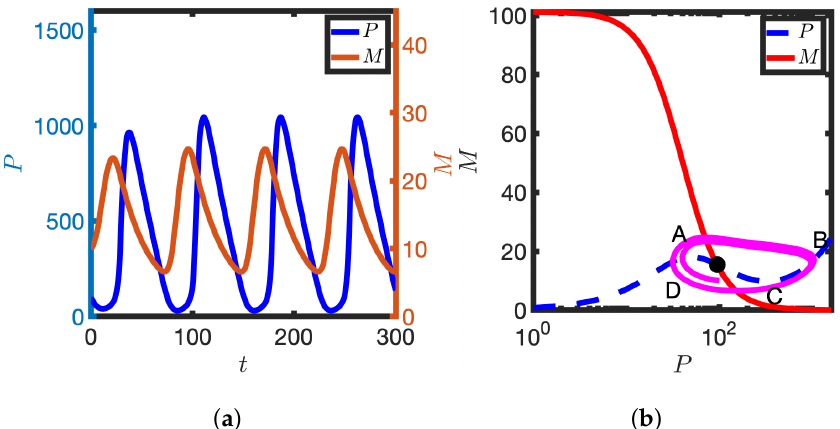
Figure 5. Oscillatory solutions of Equation (2). ( a ) P and M are plotted against time, t . ( b ) Corre- sponding solution (magenta line) is plotted in the PM phase plane. P nullcline (dashed blue line), M nullcline (solid red line), steady states (black dot). See Table 1 for parameter values.